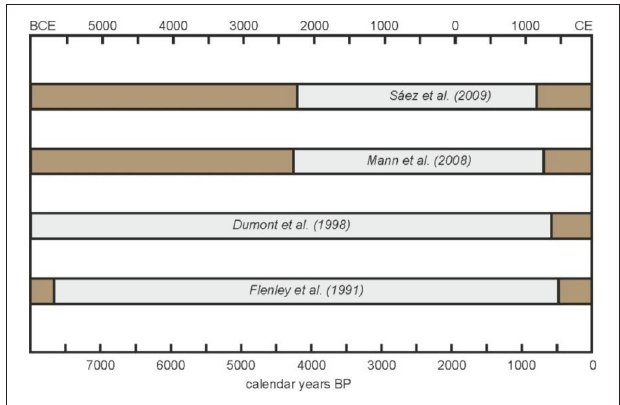
FIGURE 2 | Sedimentary gaps (gray bars) from previous paleoecological analyses on Rano Raraku sediments, from where most paleoecological inferences have been obtained. Redrawn from Rull et al.